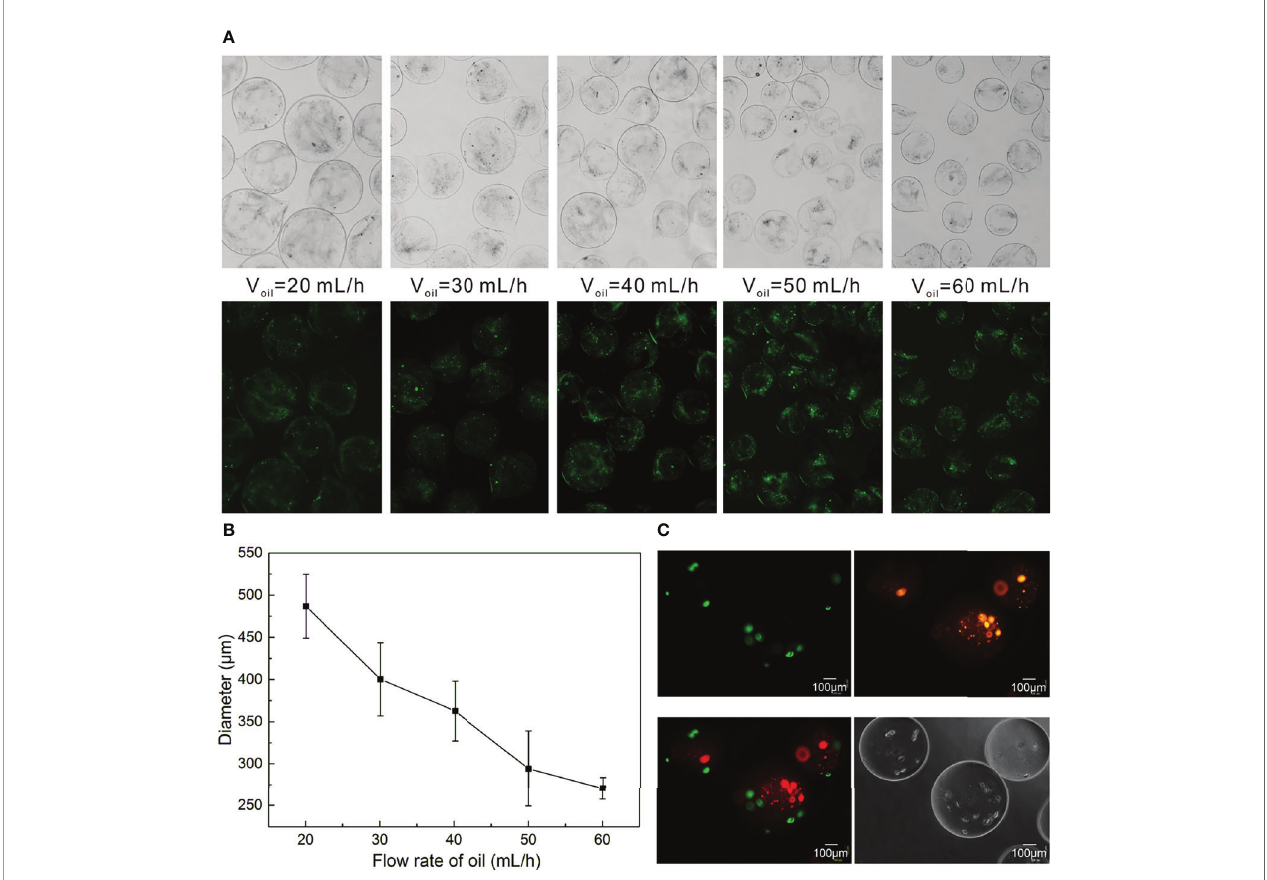
FIGURE 4 | Preparation of Bilayer Microspheres. (A) Morphology diagram of the size of the microspheres as a function of the oil fl ow rate; (B) Statistical diagram of the size of the microspheres as a function of the oil fl ow rate; (C) Morphology images of the bilayer